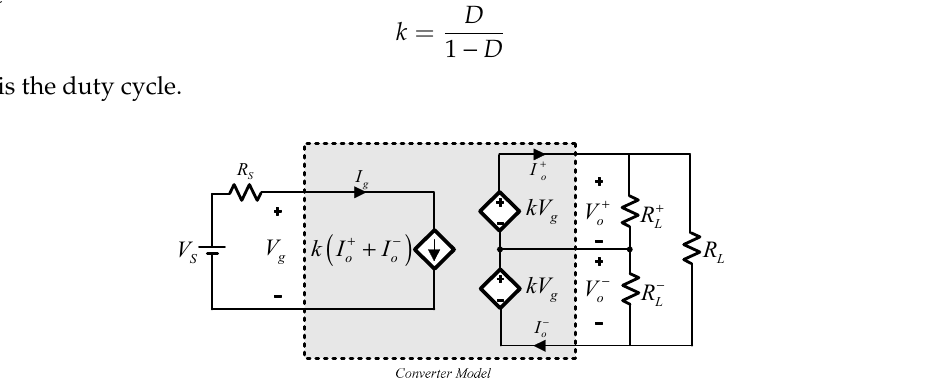
Figure 4. Converter model with controlled sources.